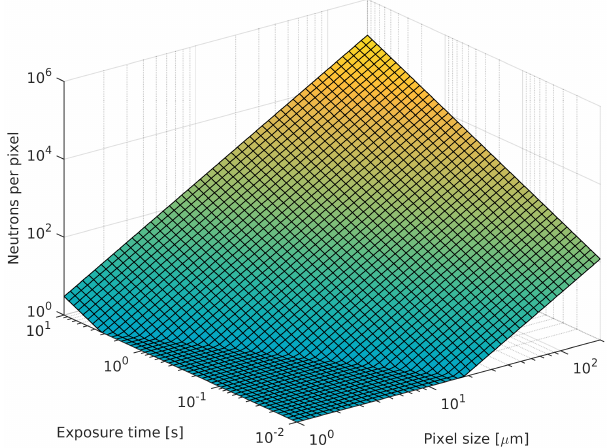
Figure 1. Average number of neutrons per pixel as a function of exposure time and pixel size calculated for a neutron flux of 10 7 neutronscm − 2 s − 1